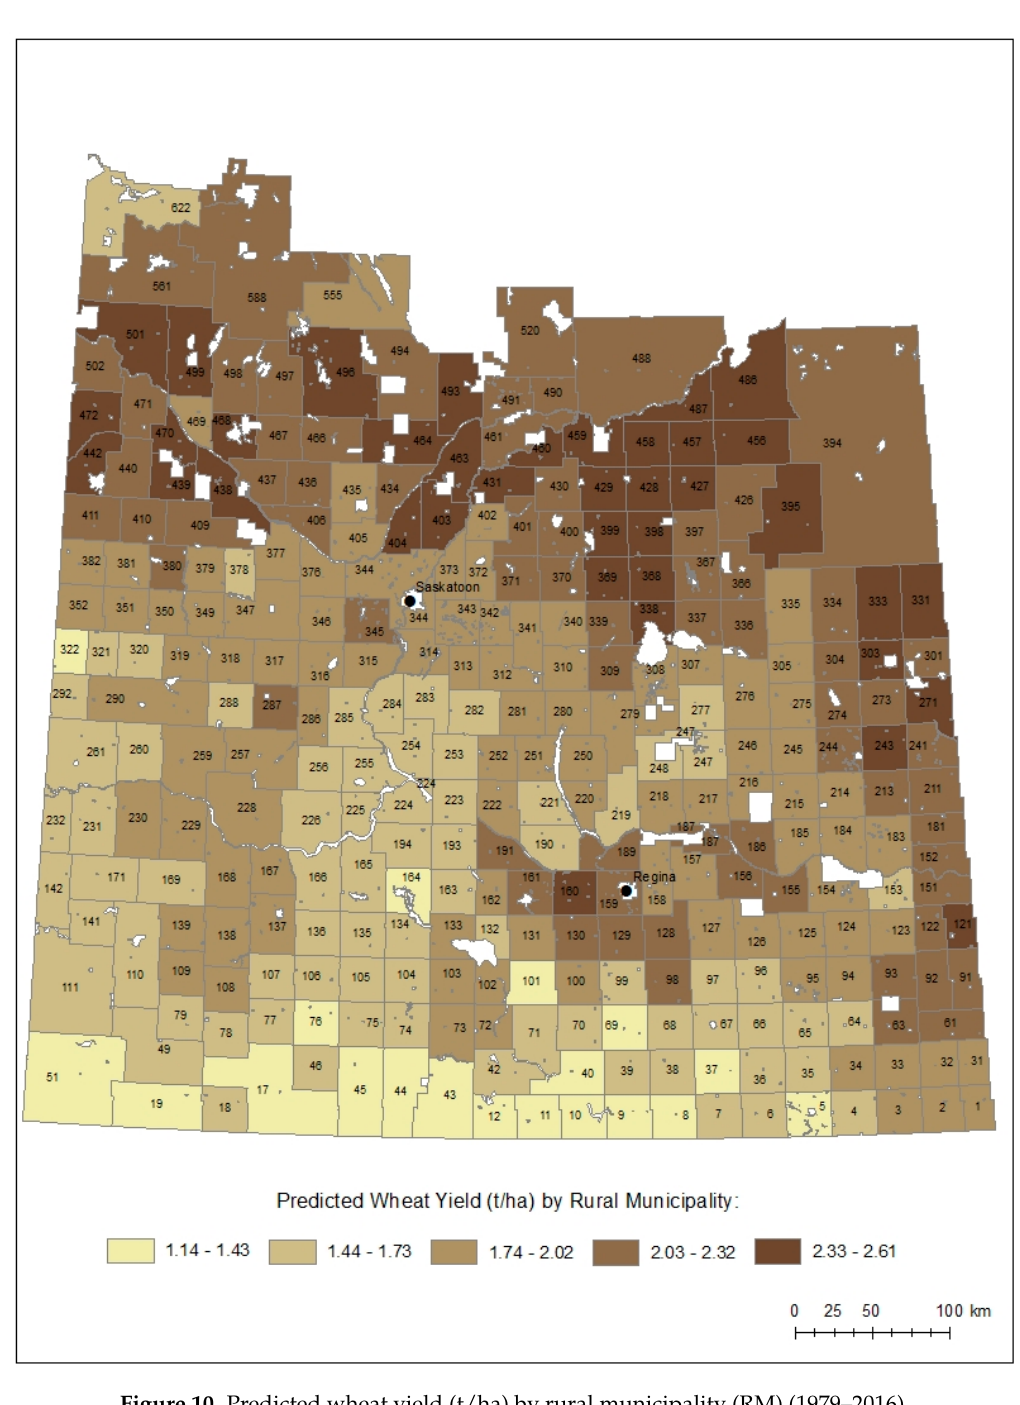
Figure 10. Predicted wheat yield (t/ha) by rural municipality (RM) (1979–2016).